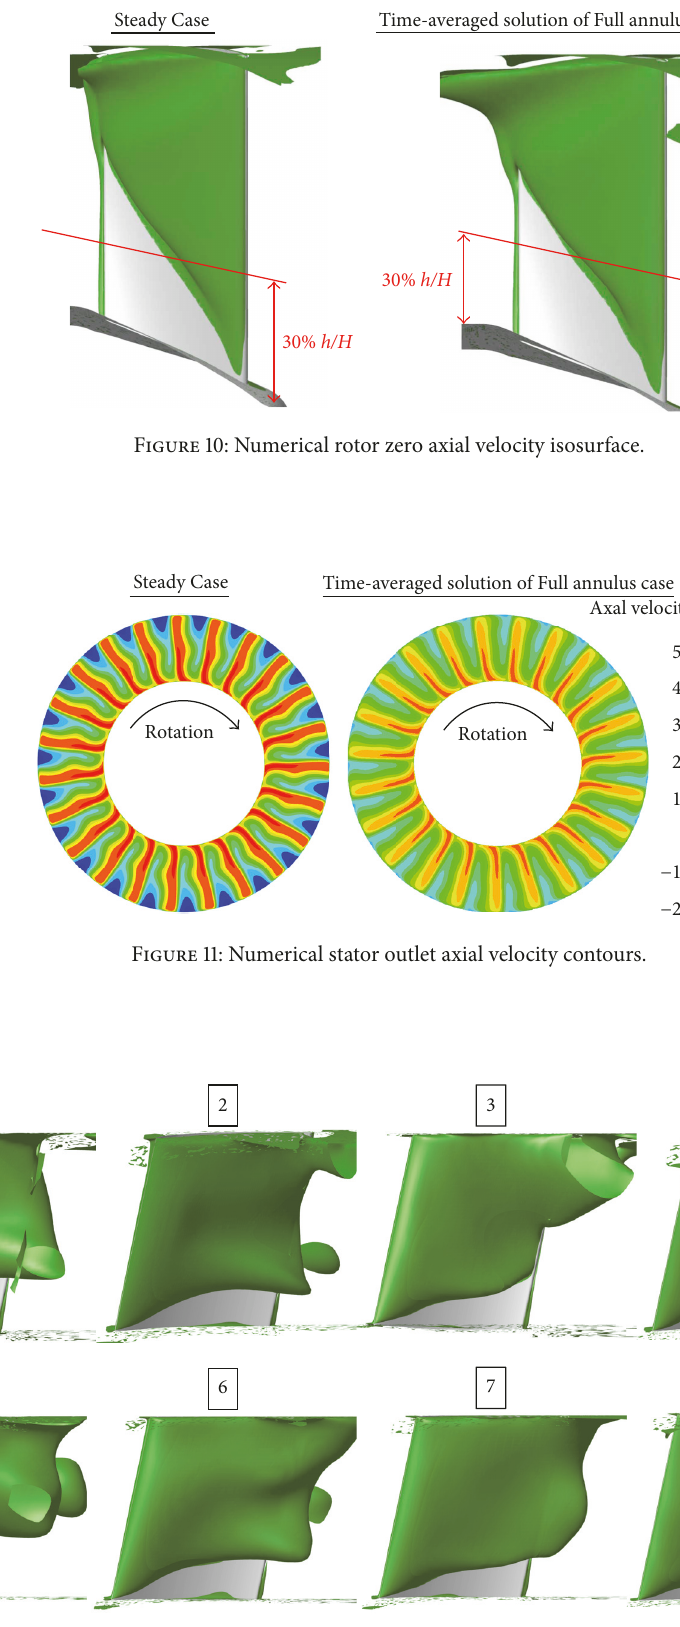
Figure 12: Numerical zero axial velocity isosurfaces on stator blades at a given time step for 8 successive